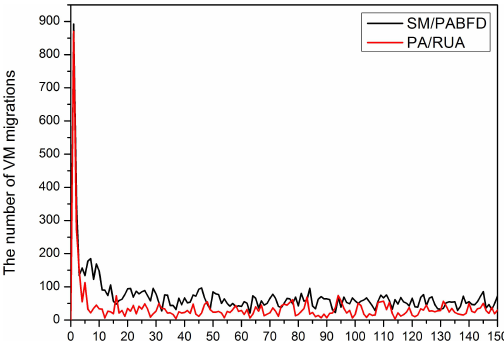
Figure 13. The number of VM migrations varies with